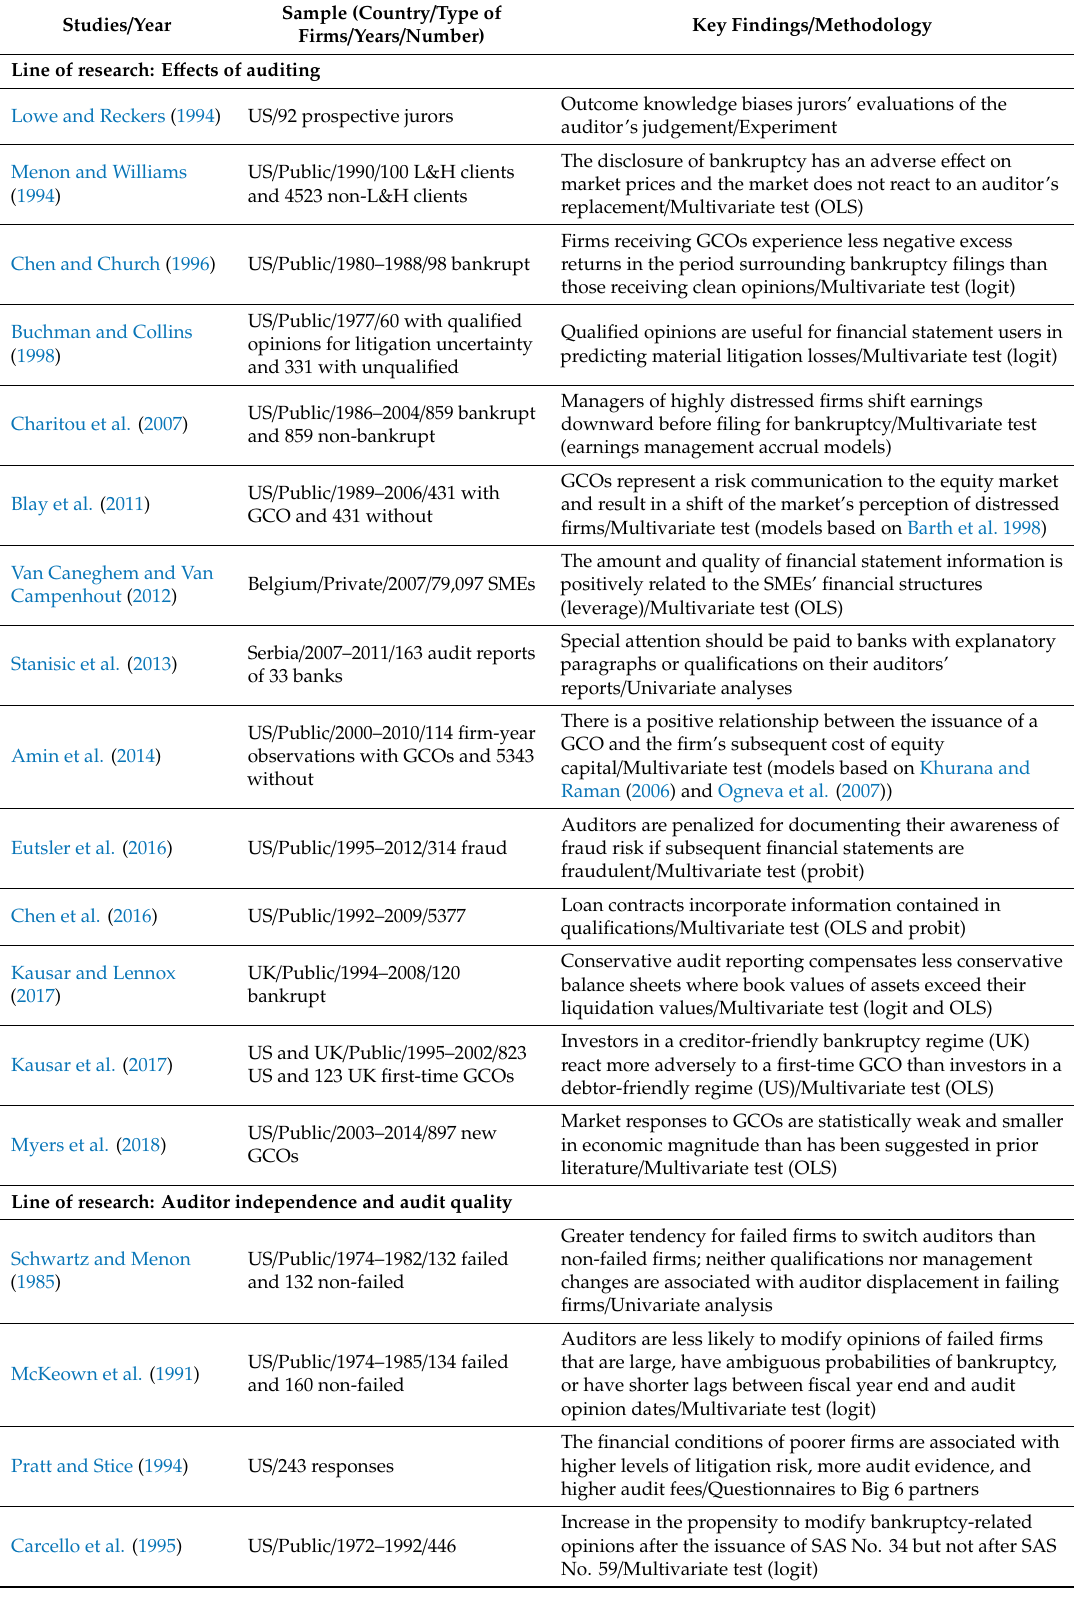
Table 1. Literature review of bankruptcy and